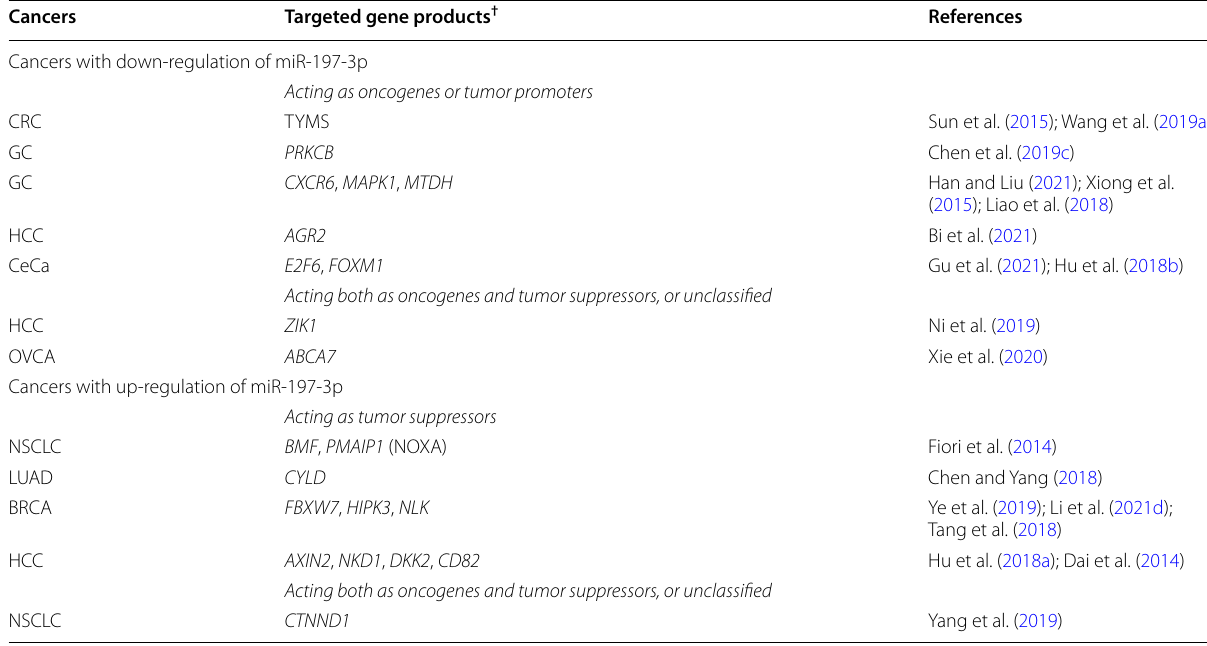
Table 7 Major genes targeted by miR-197-3p in various types of cancer